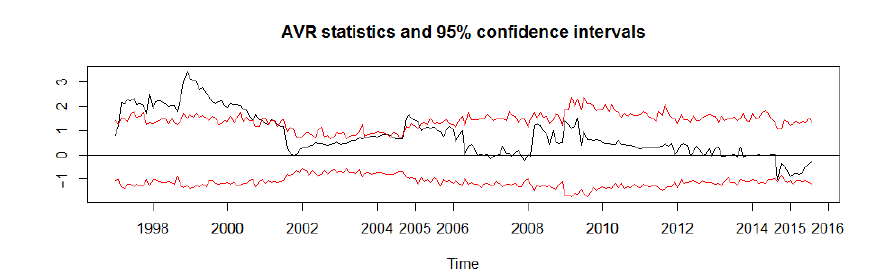
Figure 2. Evolution of Automatic Variance Ratio (AVR) statistic with subsample window of 3 years